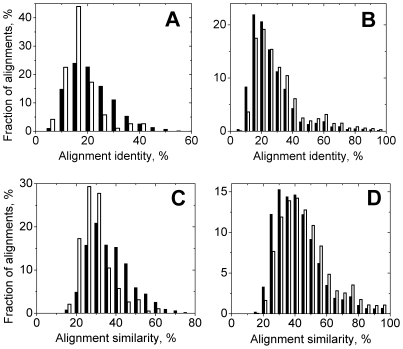
Comparison of distributions of alignment identities and similarities between alignments containing all interface residues and all alignments.The distributions of alignments containing all interface residues are shown by open bars and those of all alignments are shown by closed bars. Panels A and C show distributions for the alignments with maximum query sequence coverage 40% and panels B and D show the distributions for the whole alignment pool irrespectively of query sequence coverage.